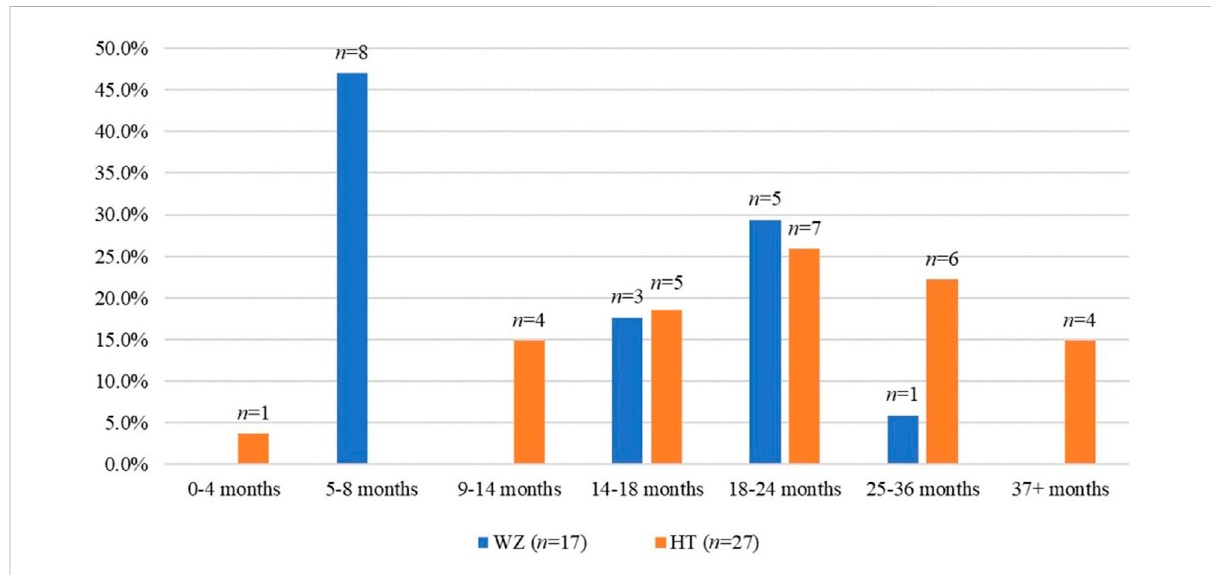
FIGURE 3 Mortality pro fi les for pigs from the WZ and HT contexts (based on dental